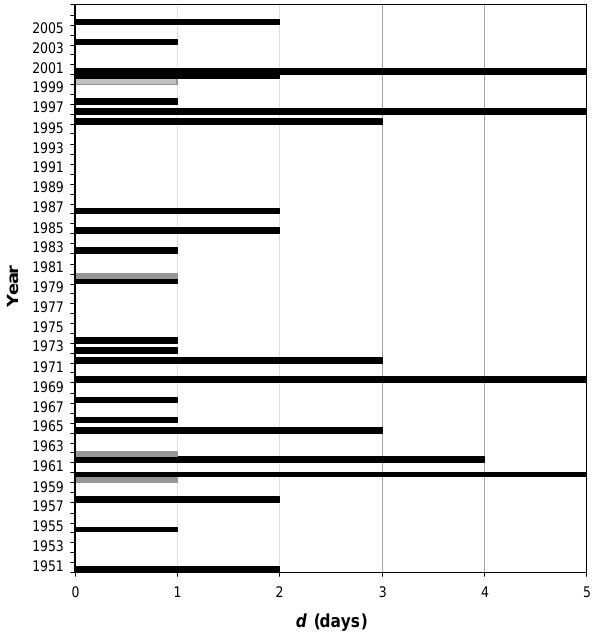
Fig. 5. The durations (in days) of the discharge above Q A = 1690m 3 s − 1 for Szczucin gauging station (1951–2006). The annual maximal durations are in